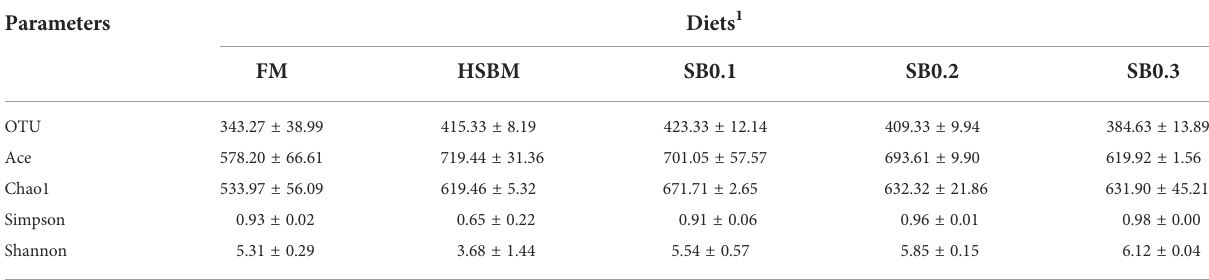
TABLE 8 Richness and diversity index of bacterial community for different samples in distal intestine of